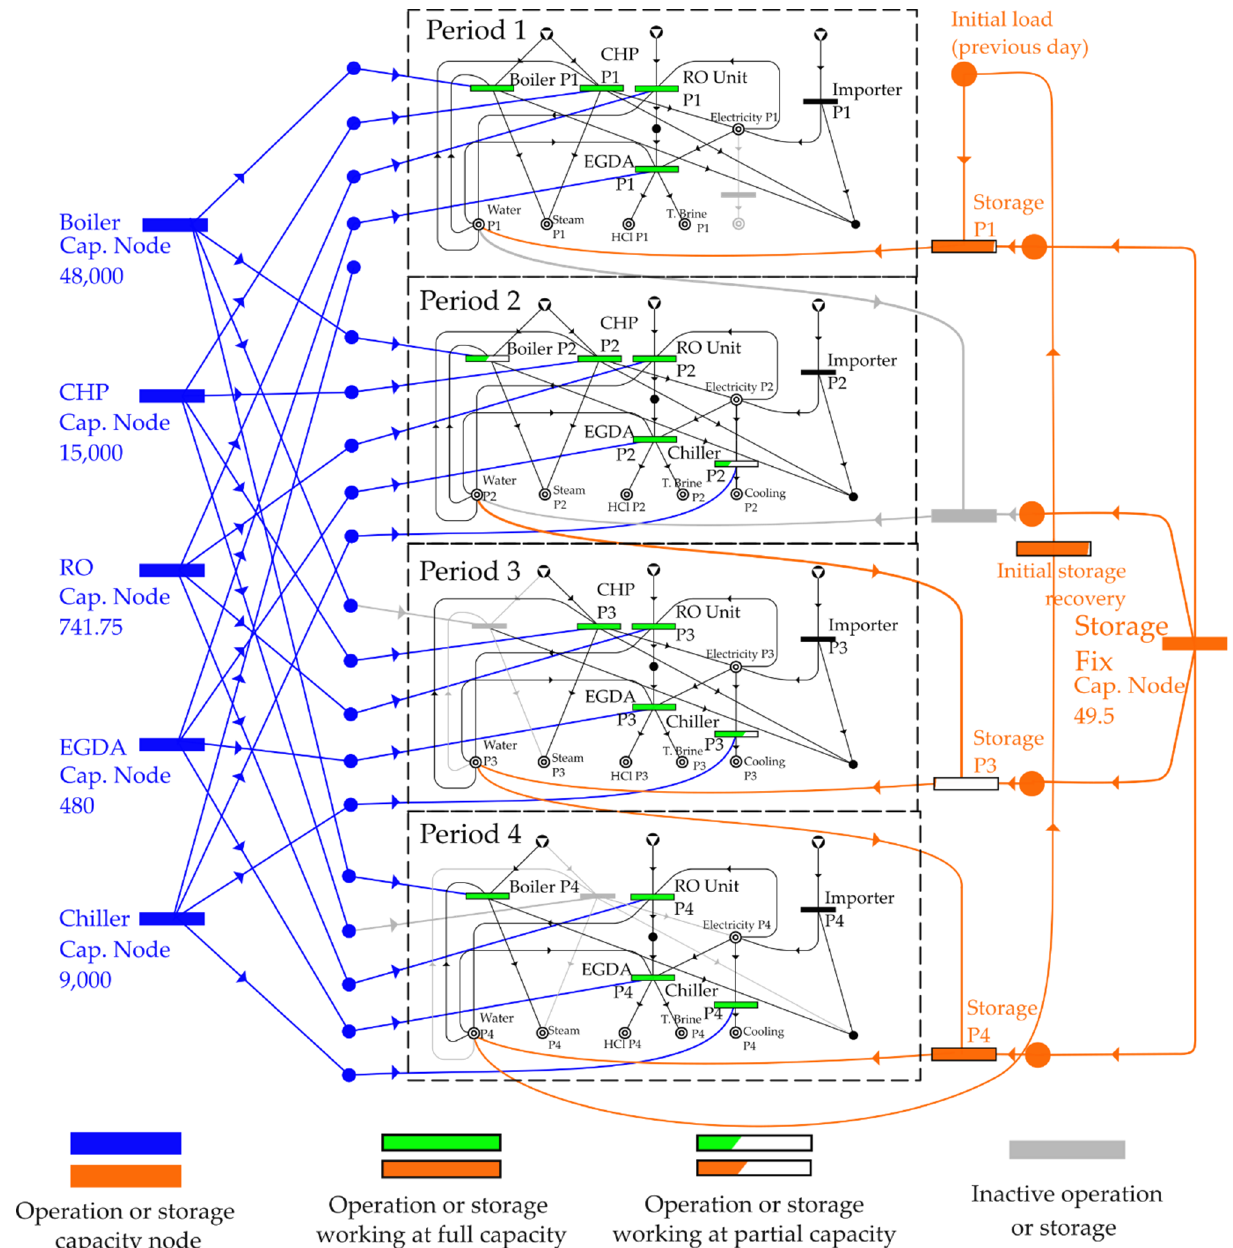
Figure 5. Best solution in terms of profit for illustrative example of 4 periods.